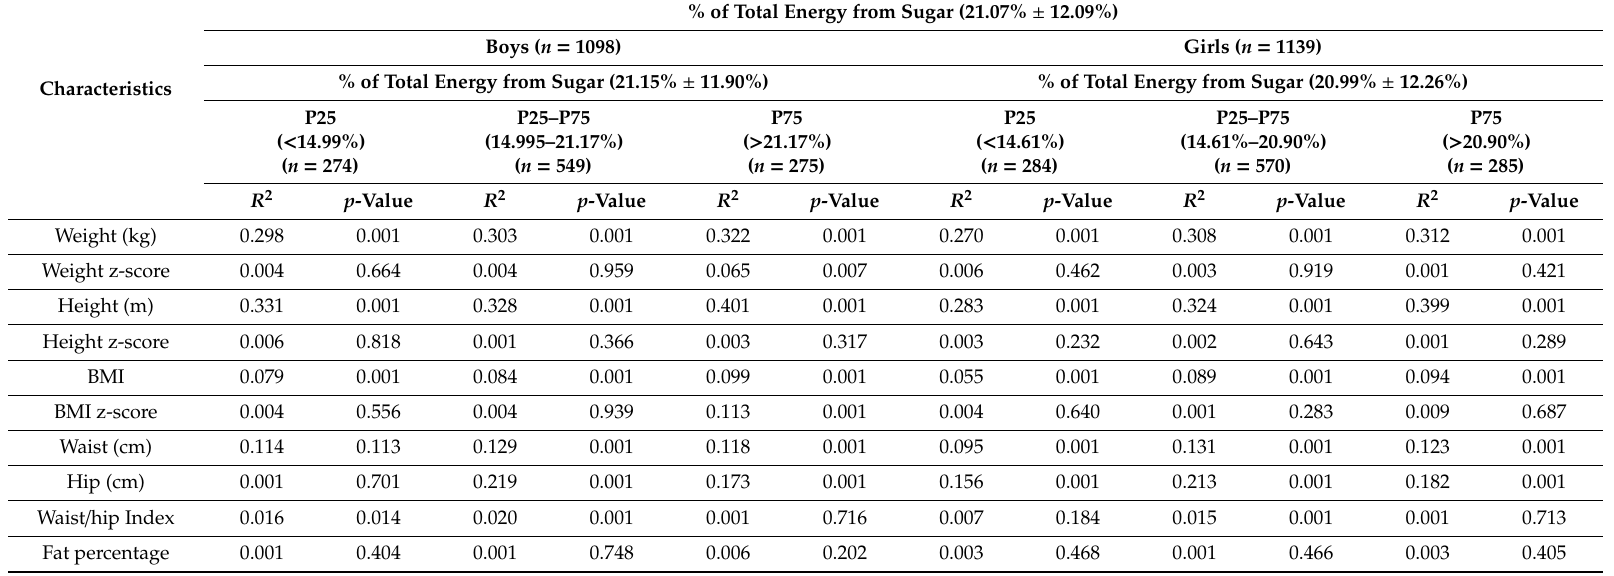
Table 7. Results of the adjusted multiple regression analysis of the possible association between anthropometric variables and the percentage of total energy derived from total sugar intake by 6–8 years old children ( n = 2237) in Valencia, Spain,